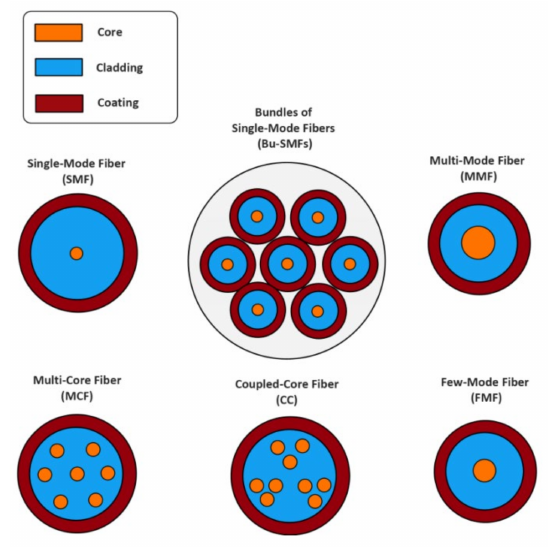
Figure 7. Different types of